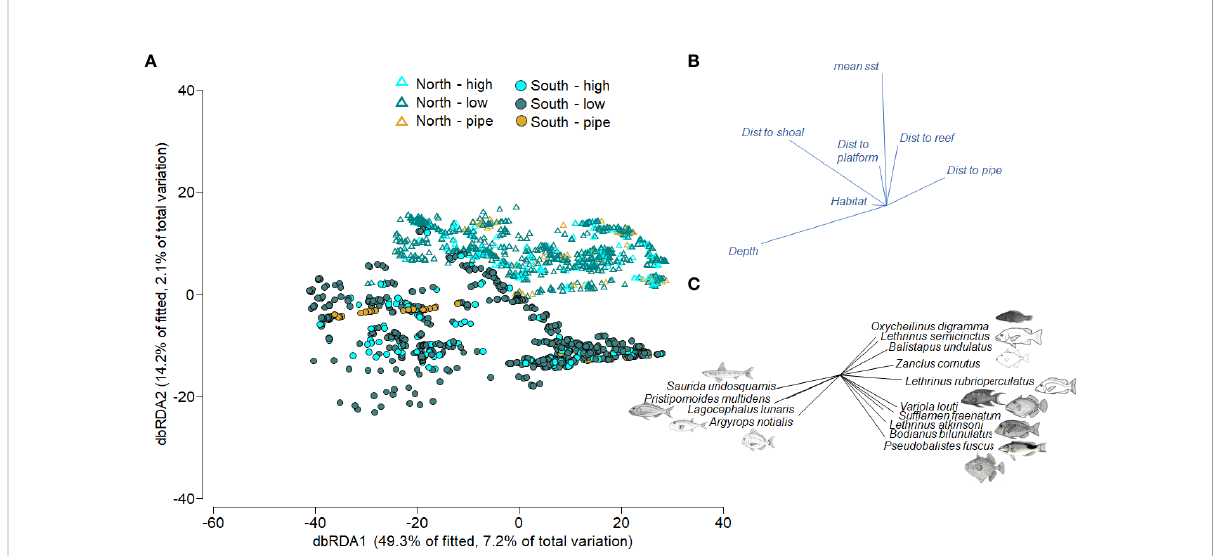
FIGURE 3 (A) dbRDA ordination plot displaying relationships between predictor variables and fi sh relative abundance data (MaxN of all species). Colours represent sea fl oor complexity (low & high refer to sea fl oor complexity; pipe = pipeline) while symbols represent regions along the coast of NW Australia (south = Pilbara and Dampier, north = Broome and Darwin). (B) Vectors indicate the direction of the relationship, and their length indicates the strength of their effect on fi sh abundance. (C) Fish species with Pearson correlations of |R| ≥ 0.30 to either axis are overlaid with vectors in the bottom right indicating the strength and direction of this association, i.e. how these fi sh species correlate with sea fl oor complexity categories and regions and predictor